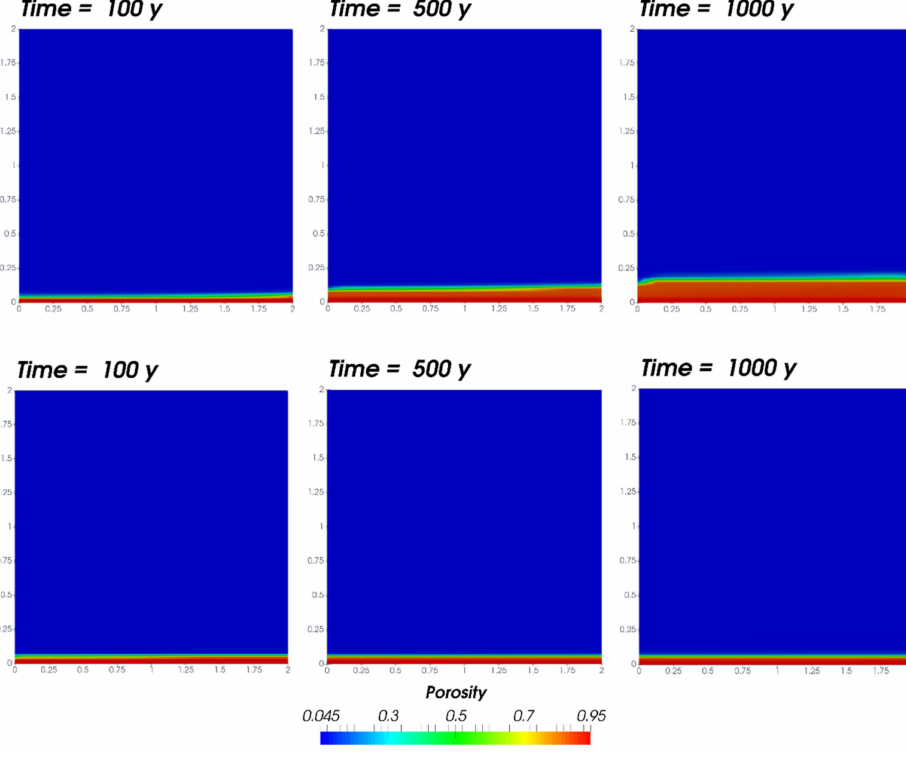
Figure 8. Spatial distribution of the porosity after 100, 500, and 1000 years of simulation in scenario 2 computed with ( top ) and without ( bottom ) the porosity feedback